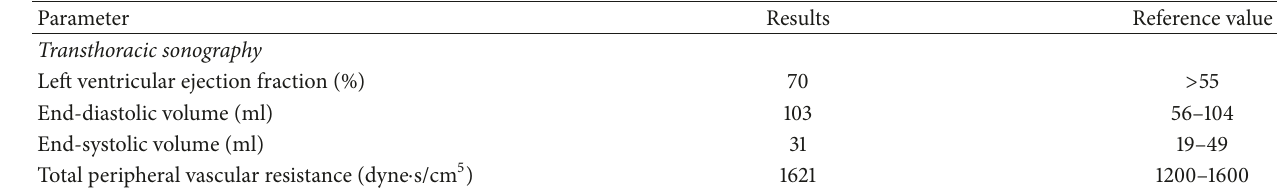
Table 2: Cardiac